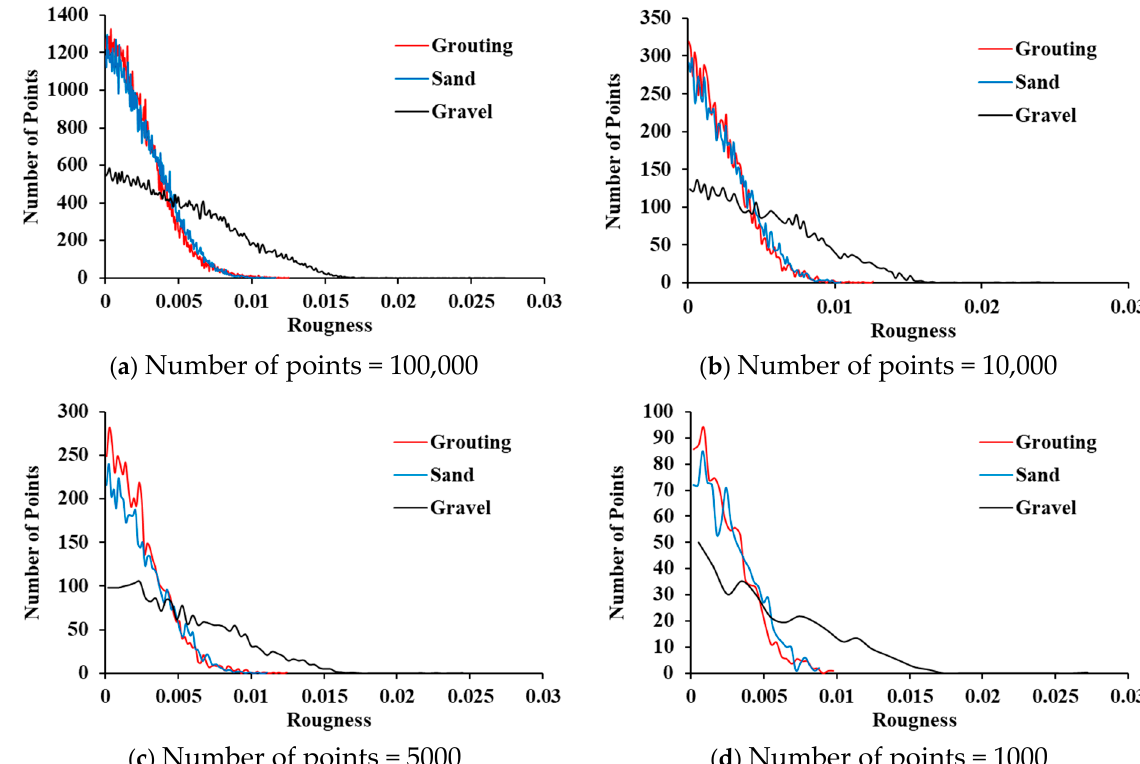
Figure 13. Effect of point cloud density on roughness. Table 1. Comparison of roughness between original point cloud and subsampled point clouds.